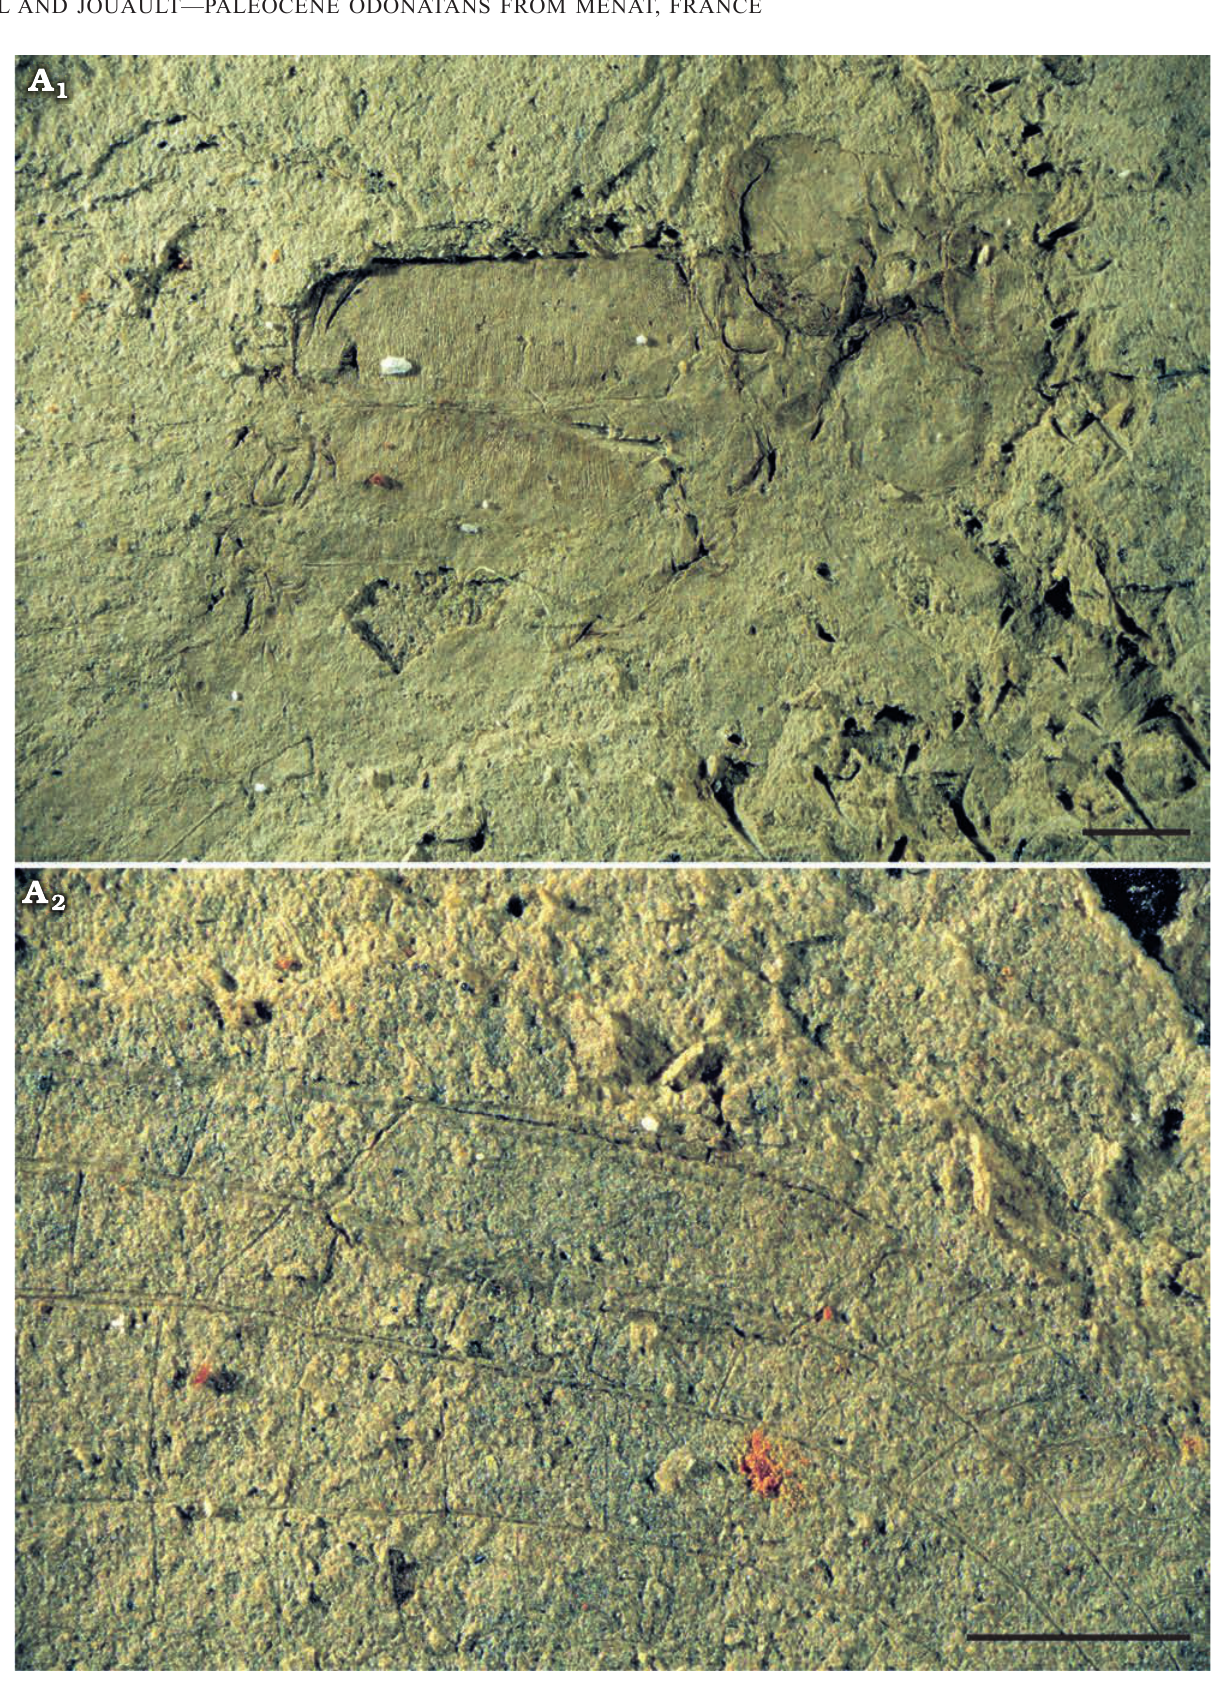
Fig. 9. Zygopteran odonatan Menatlestes palaeocenicus gen. et sp. nov., holotype MNT Nel Odo 2; from Paleocene, Menat, France. Head and thorax (A 1 ), pterostigma (A 2 ) . Scale bars 1